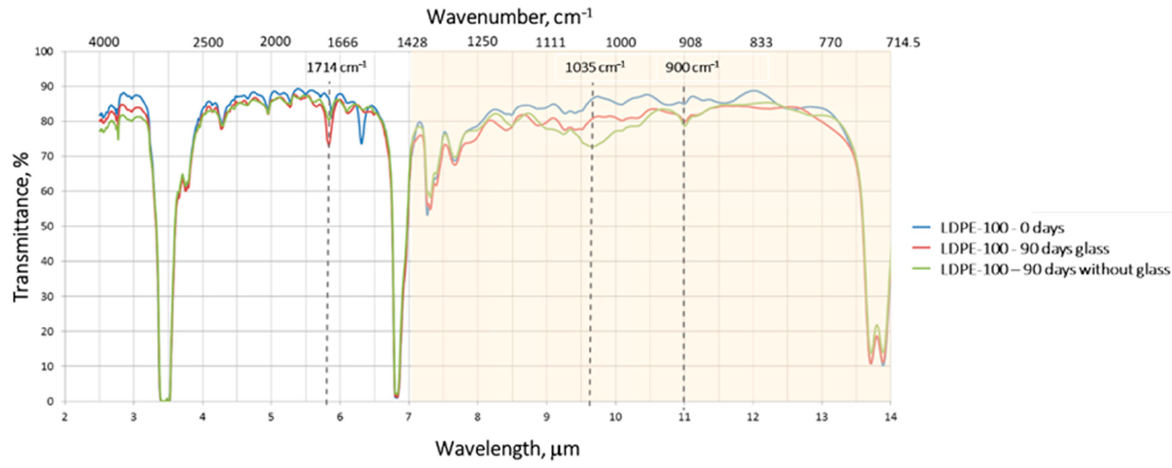
Figure 8. LDPE-100 FT-IR spectra in transmission mode.